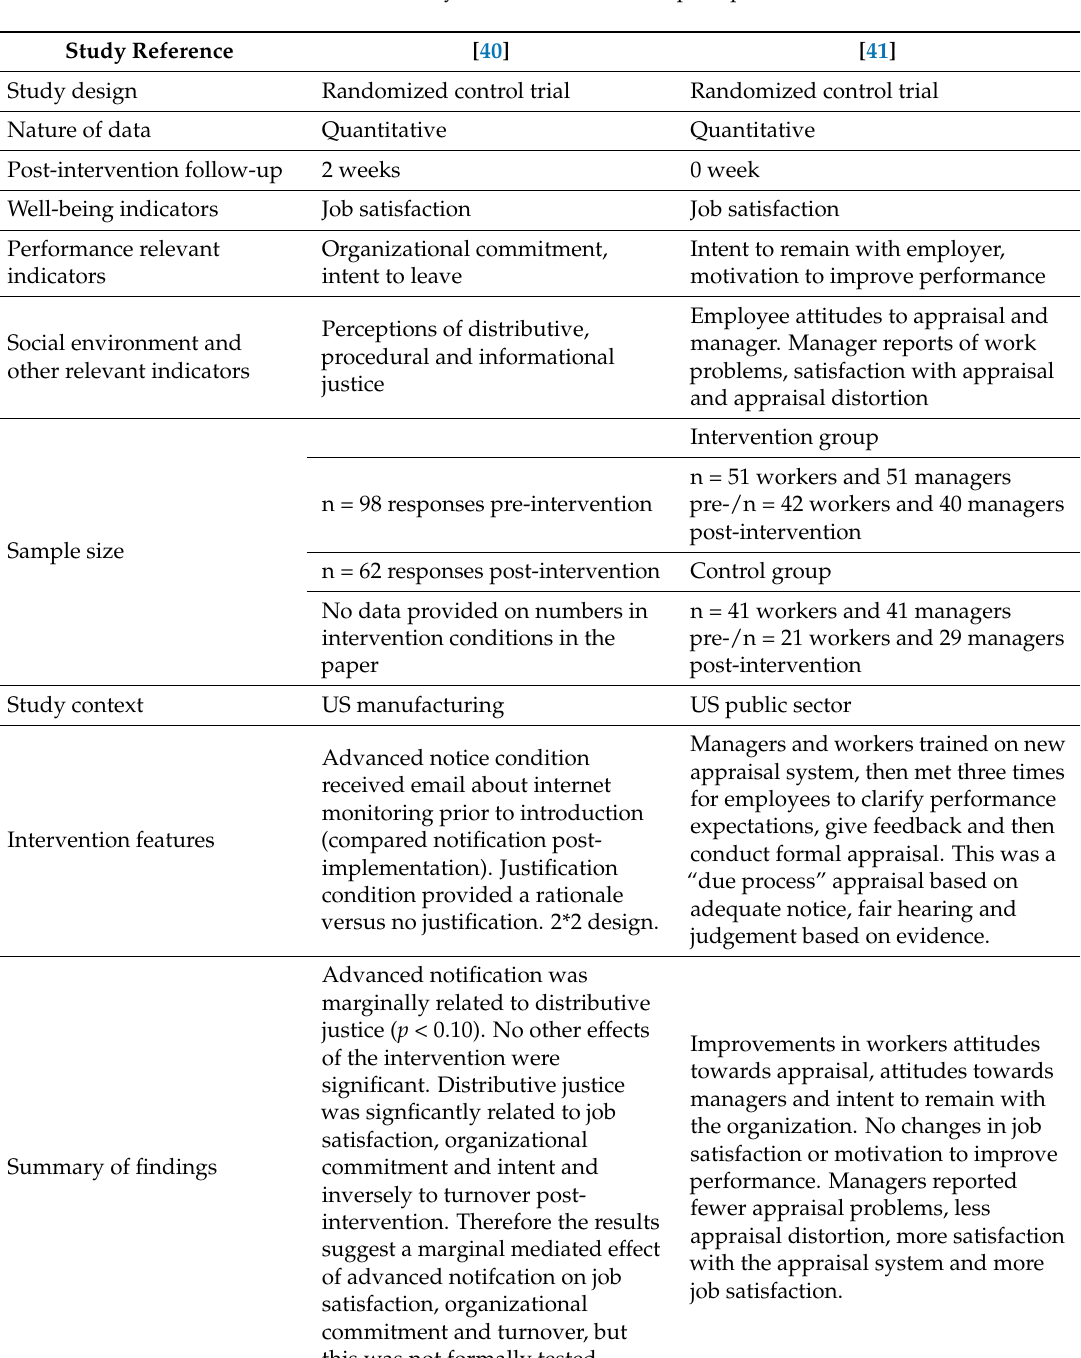
Table 3. Summary of studies on fairness